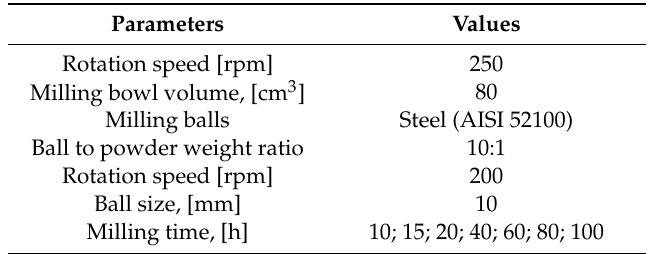
Table 1. Experimental parameters of the ball milling process.